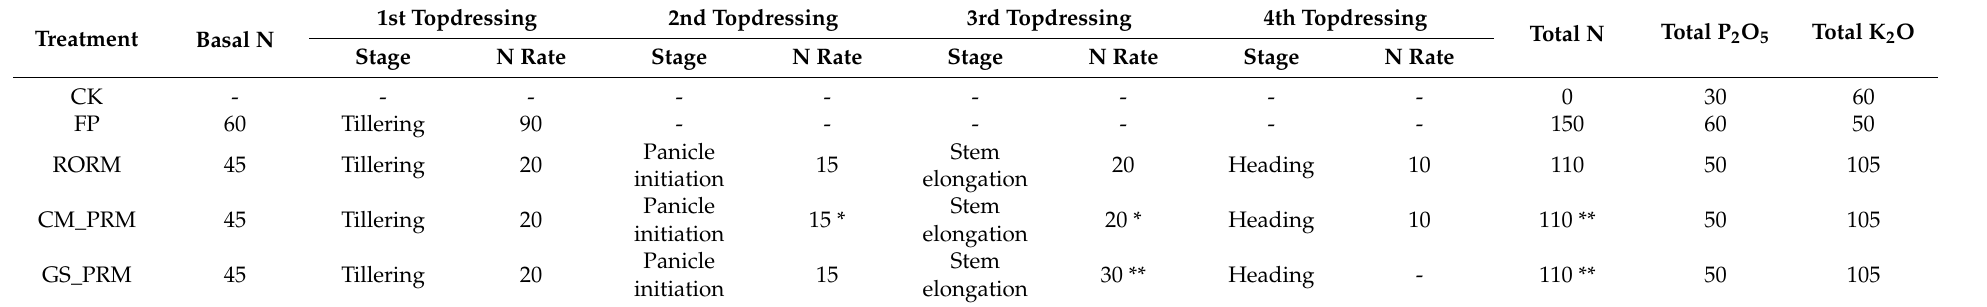
Table 1. Fertilizer application rates (kg ha − 1 ) and timing for different rice management systems in the two field experiments for two varieties from 2011–2013.